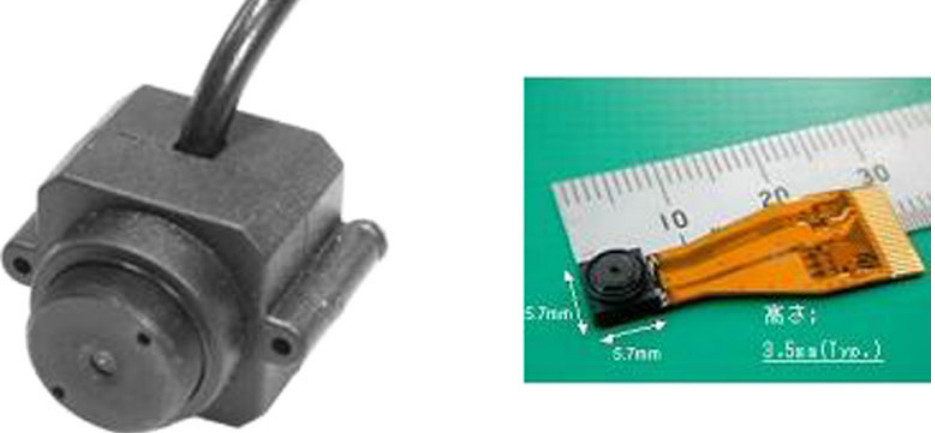
Figure 4 Left: A standard CMOS analog camera; right: Fujitsu CMOS VGA digital camera (picture adopted from Web site http://www.fujitsu.com; Fujitsu Ltd.